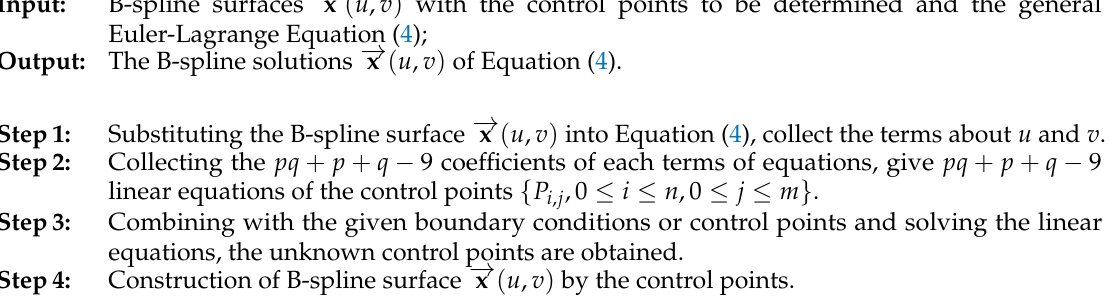
Algorithm 2 Algorithm to get the B-spline solution of the Euler-Lagrange Equation